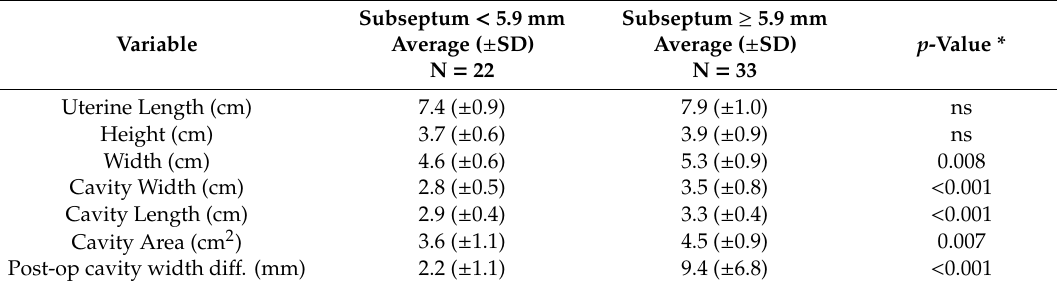
Table 2. Pre-operative uterine and uterine cavity measurements in the new 55 patients with uterine subseptations, further divided into subseptations < 5.9, and ≥ 5.9 mm. Subseptum < 5.9 Variable